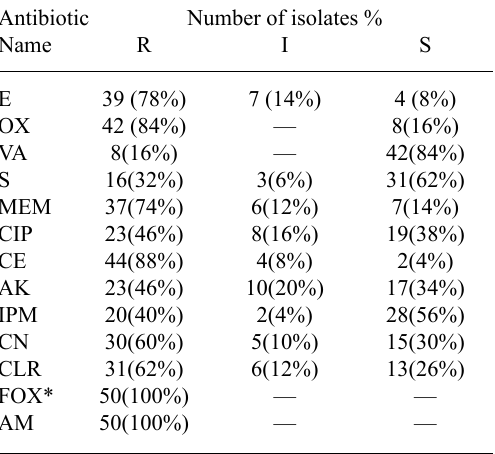
table 9. Detection of VanA gene among